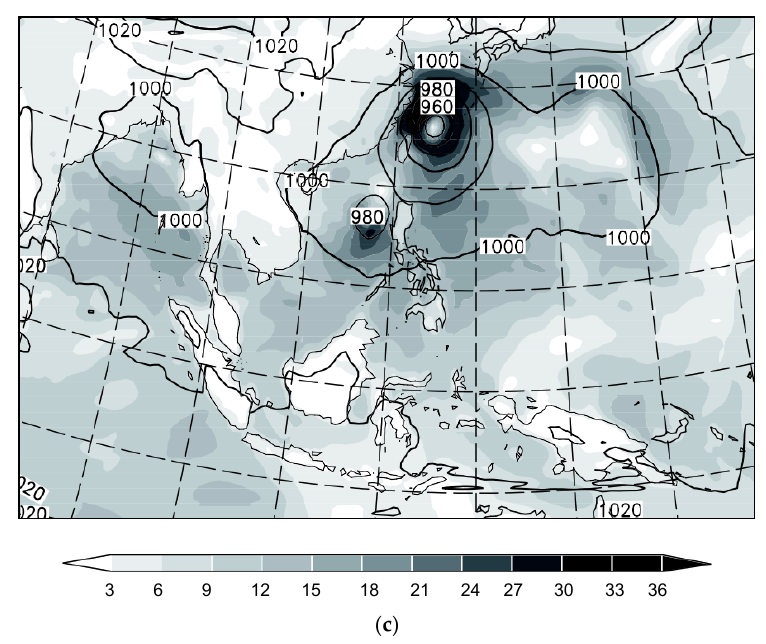
Figure 2. Simulated sea level pressure (hPa; isobars) and near-surface wind speed fields (ms −1 ; shaded) of typhoon Winnie representing 0000 UTC 17 August 1997. ( a ) With constraining; ( b ) and ( c ) two simulations without constraining. The simulations were initialized with ( b ) conditions of 0000 UTC 3 August 1997 and ( c ) conditions of 0000 UTC 7 August 1997. (Model: COSMO-CLM; forcing: NCEP 1; 50 km grid resolution; [44], © Copyright 2008 AMS.